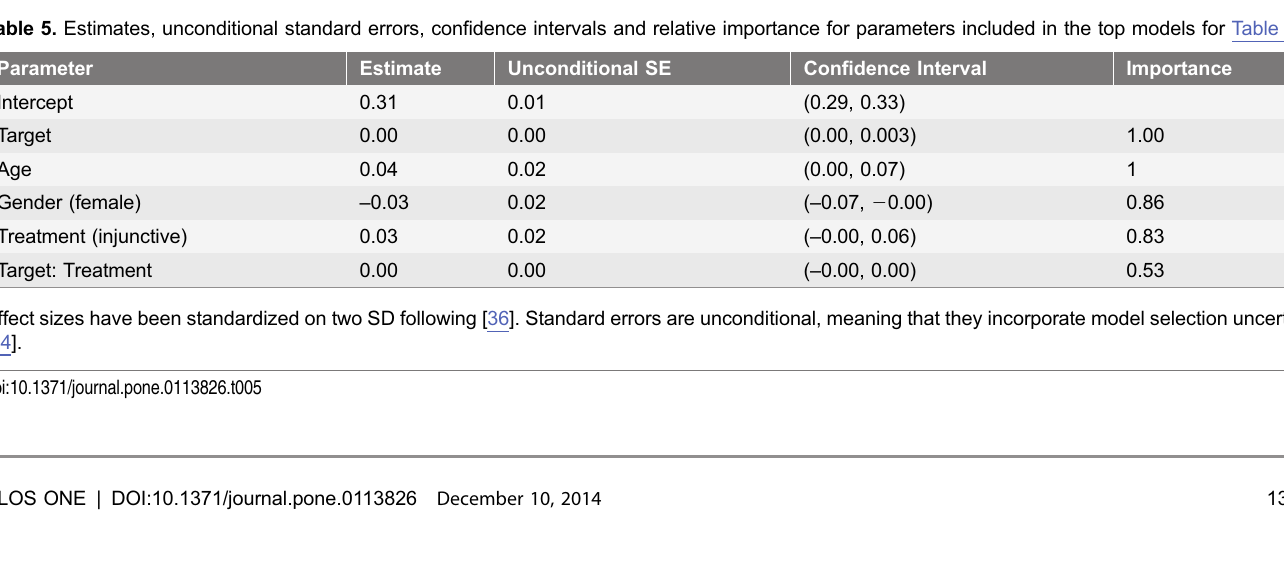
Table 5. Estimates, unconditional standard errors, confidence intervals and relative importance for parameters included in the top models for Table 4. Parameter